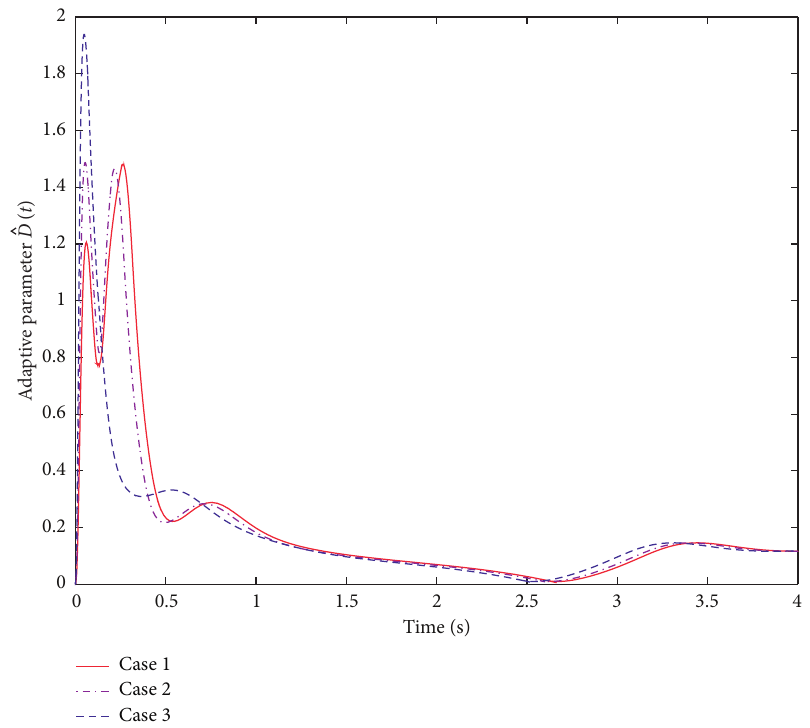
( t ) of the proposed method under three 2